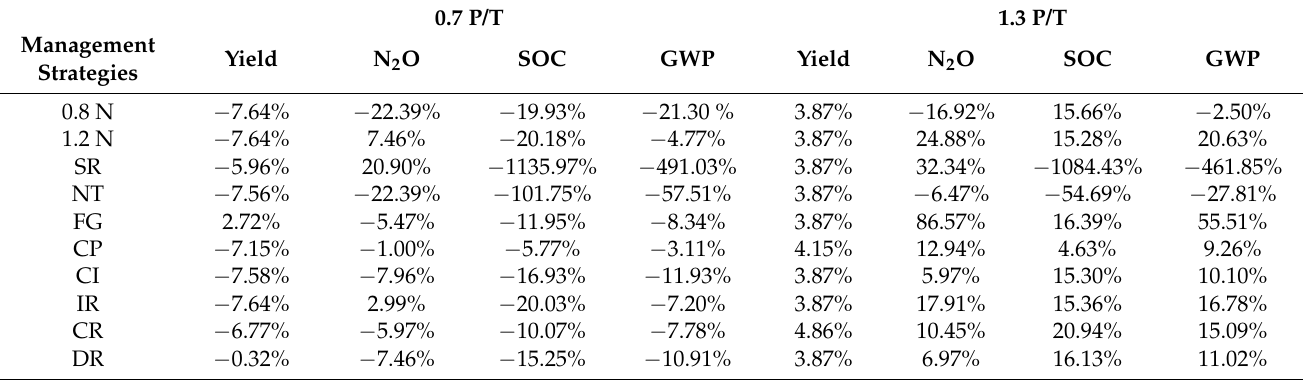
Table 5. The effects on annual yield, N 2 O emissions, and SOC loss under the 0.7P/T and 1.3P/T scenarios. 0.7 P/T 1.3